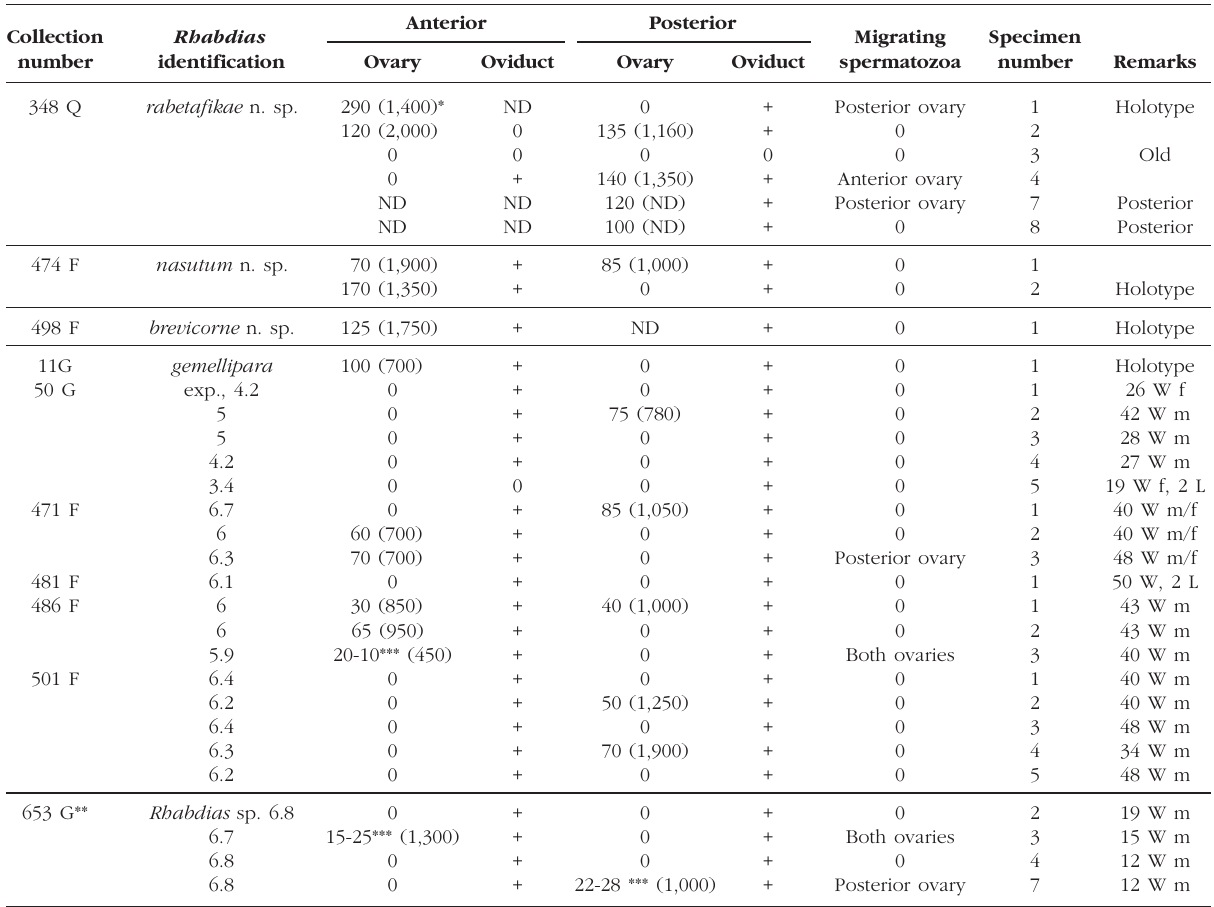
Table IV. – Male region and gametes in parasitic females of Rhabdias spp. from Malagasy